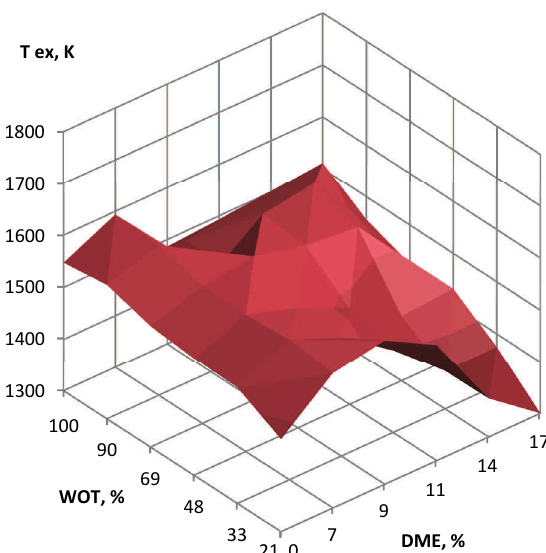
Fig. 16. An influence of DME share & engine load on temperature of raw exhaust gases, n = 2500 rpm